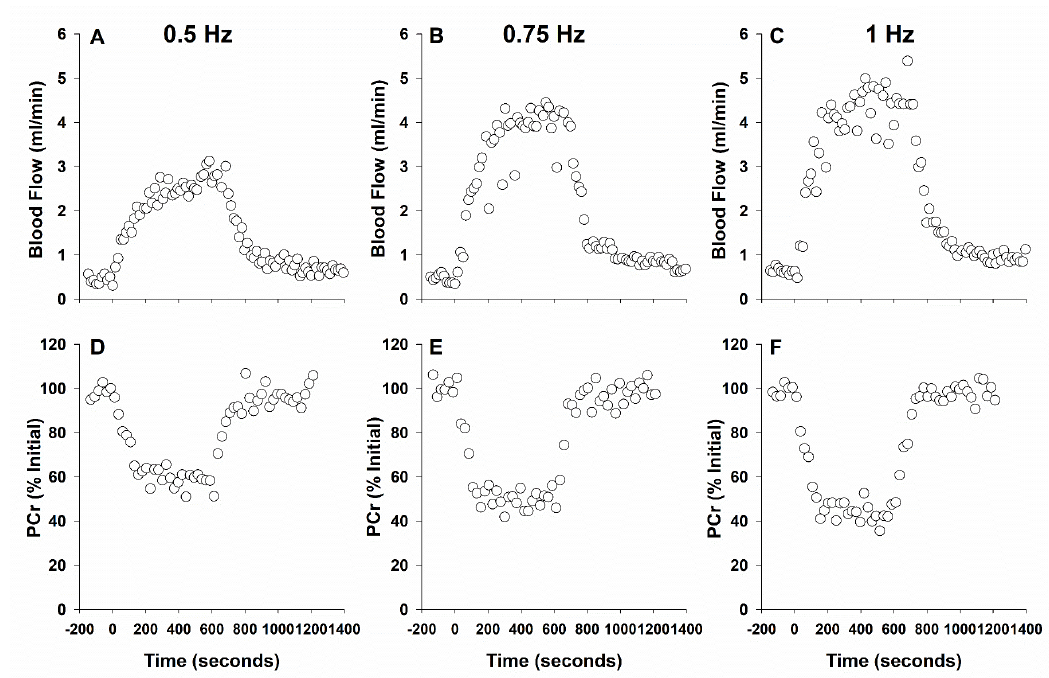
Figure 7. Experimental design measuring blood flow delivery and phosphorus energetics concurrently. As contractile intensity increases, blood flow to the muscle increases ( A – C ) and more PCr is hydrolyzed ( D – F ).